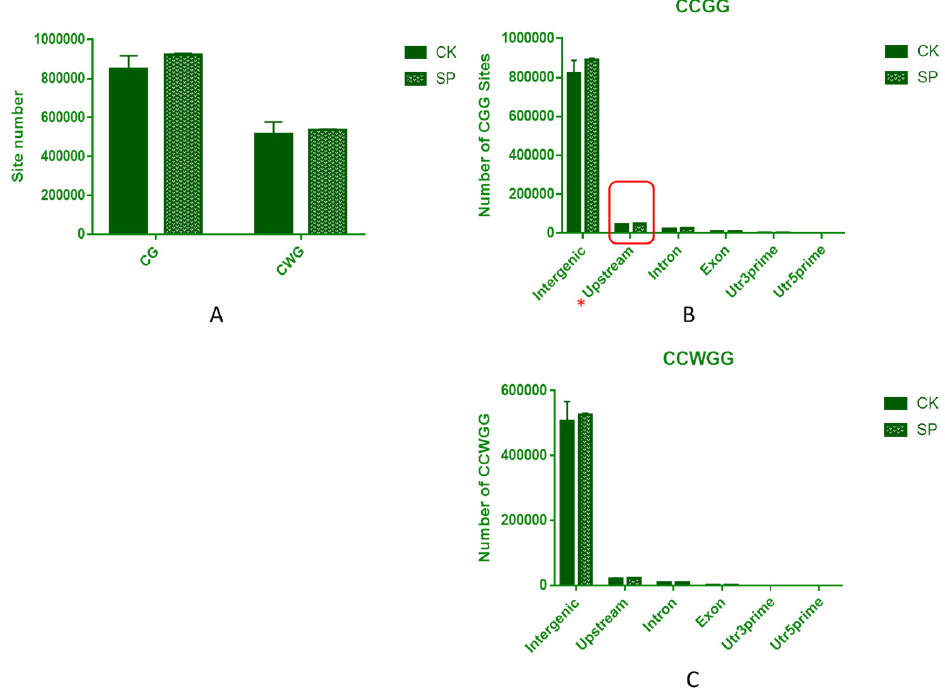
Figure 7. The methylated sites in the CG and CWG contexts: ( A ). Summary of methylated sites in the SP and CK groups. ( B , C ). Distribution of CCGG ( B ) and CCWGG ( C ) methylation sites within genome functional elements. Note: The “*” in the figure indicates a significant difference between the CK and SP groups in this element at the p < 0.05 level.